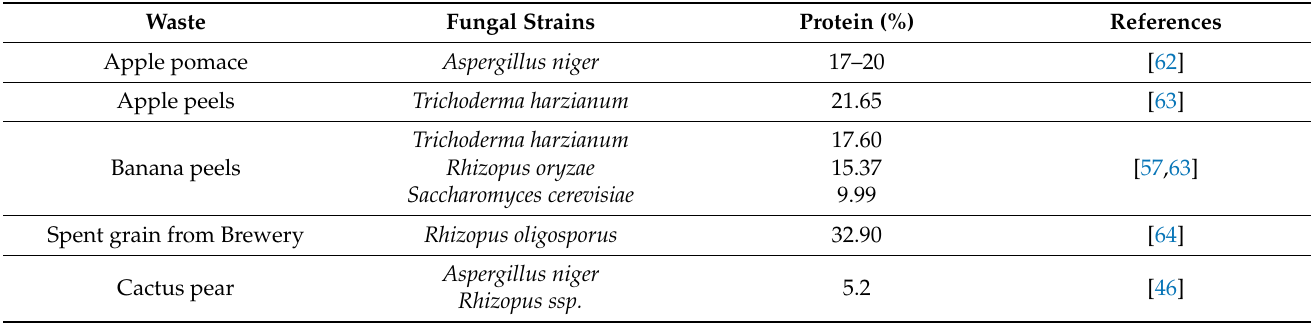
Table 1. Examples of different fungal strains that utilize different types of waste as substrate for SCP production and percent of their protein